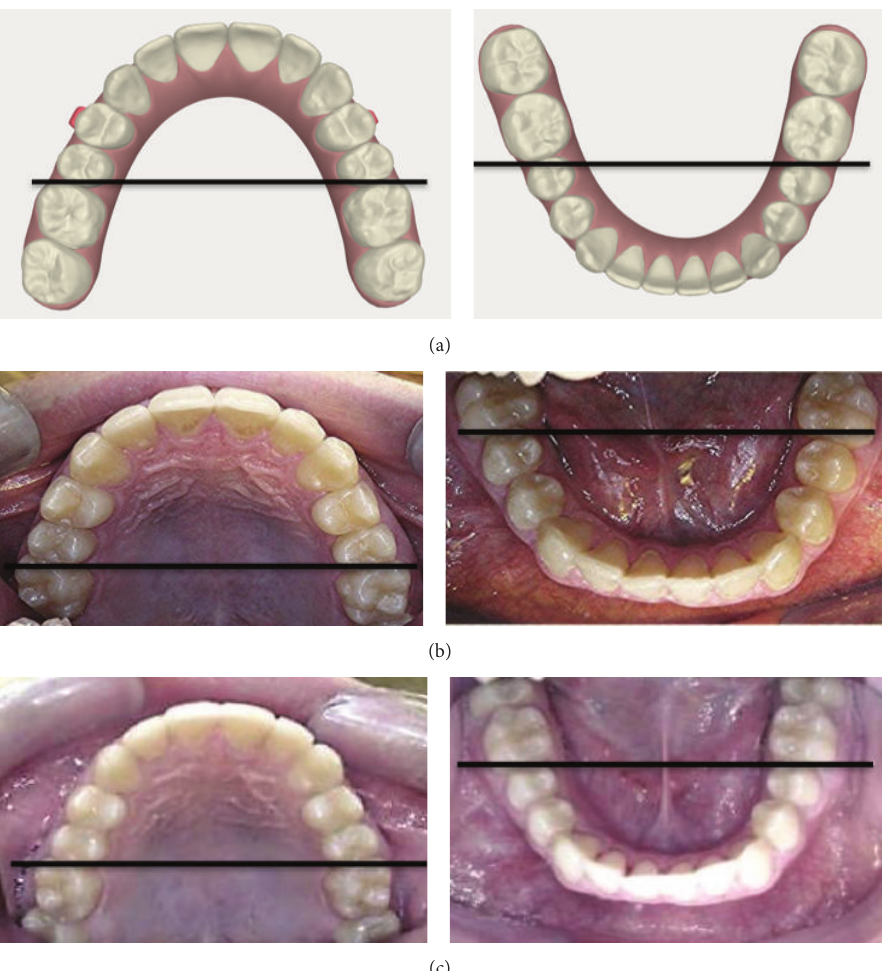
Figure 14: Posttreatment comparison of the interarch symmetry. (a) Clinical check evaluation at the end of the treatment; (b) clinical evaluation at the end of the treatment; and (c) 6-year follow-up clinical